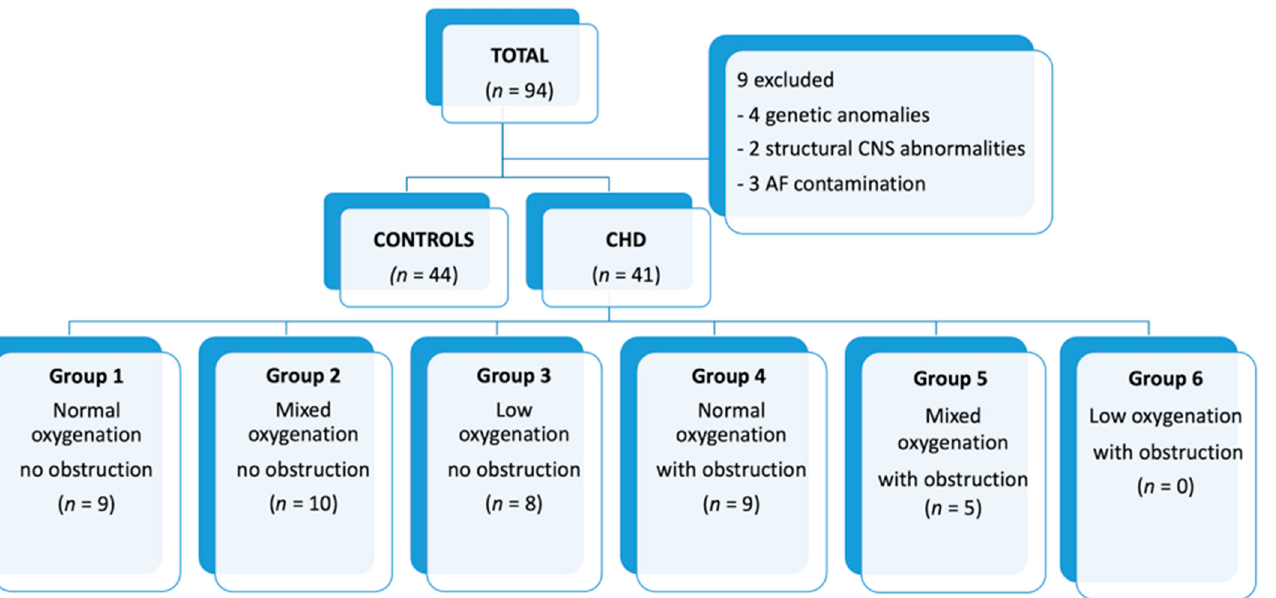
Table 1. Baseline and perinatal characteristics of the study population.